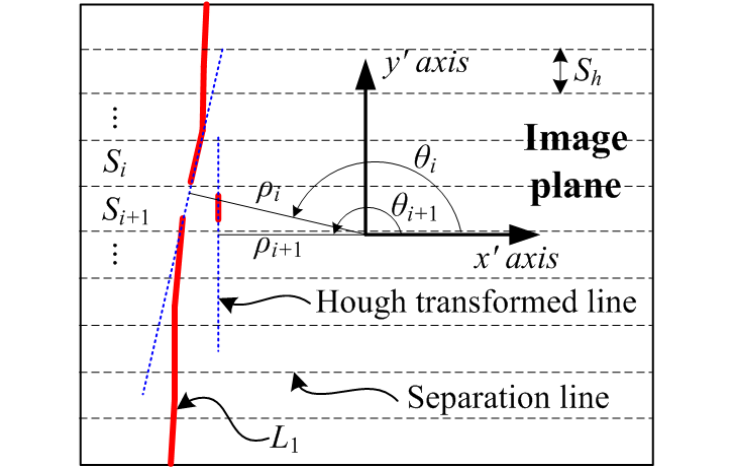
Figure 10. Separated Hough transform for obtaining the line segment of L the lug